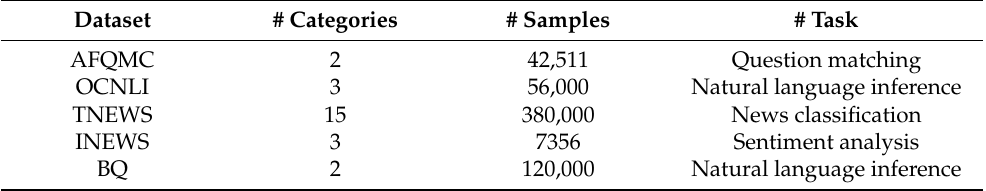
Table 1. Statistics of text classification tasks. We set the training sample size K of each category to 16, as well as the evaluation sample size and select 1000 samples for each category for